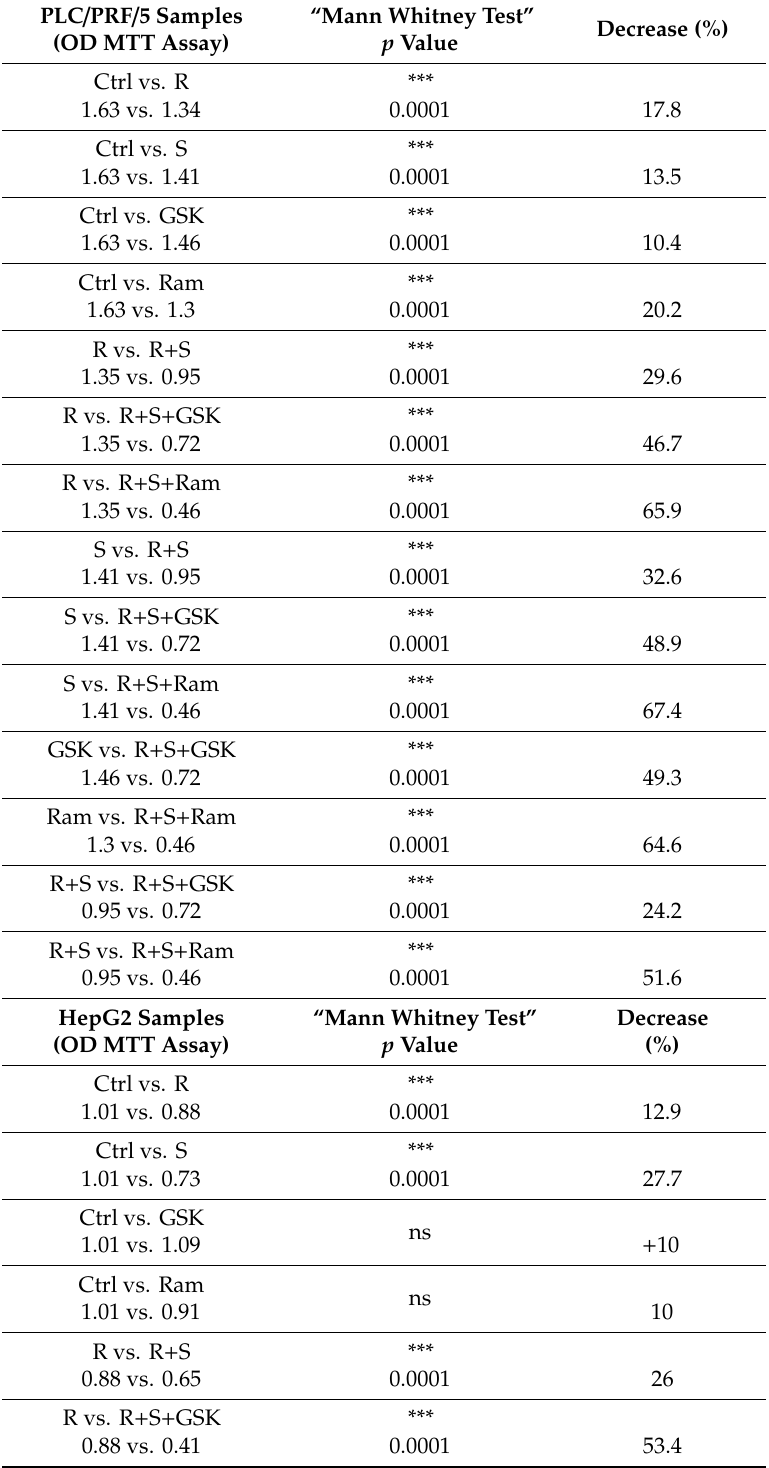
Table 1. MTT assay relative to each single or combined treatment in PLC / PRF / 5, and HepG2 cells. MTT assay performed in cells cultured with 2.5 µ M (PLC / PRF / 5) or 1 µ M (HepG2) sorafenib (S), 1 µ M (PLC / PRF / 5) or 0.1 µ M (HepG2) regorafenib (R), 3 µ M GSK1838705A (GSK) and 400 µ M ramucirumab (Ram) alone or in combination. The average value of number of colonies derived from three independent experiments, the p value and the percentage decreases for the interest group are